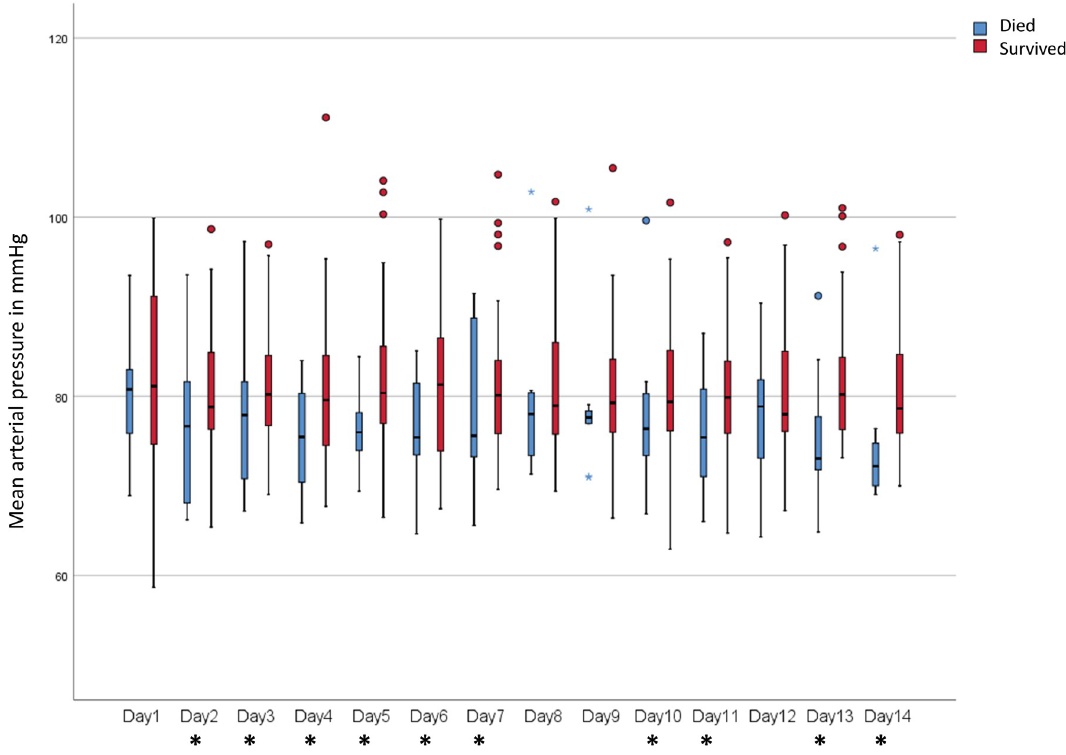
Fig 2. Daily mean arterial pressure (MAP) within the first 14 days of intensive care treatment: non-survivors had lower MAP values on most days than survivors. Significant differences are marked with an asterisk in the legend of the x-axis.